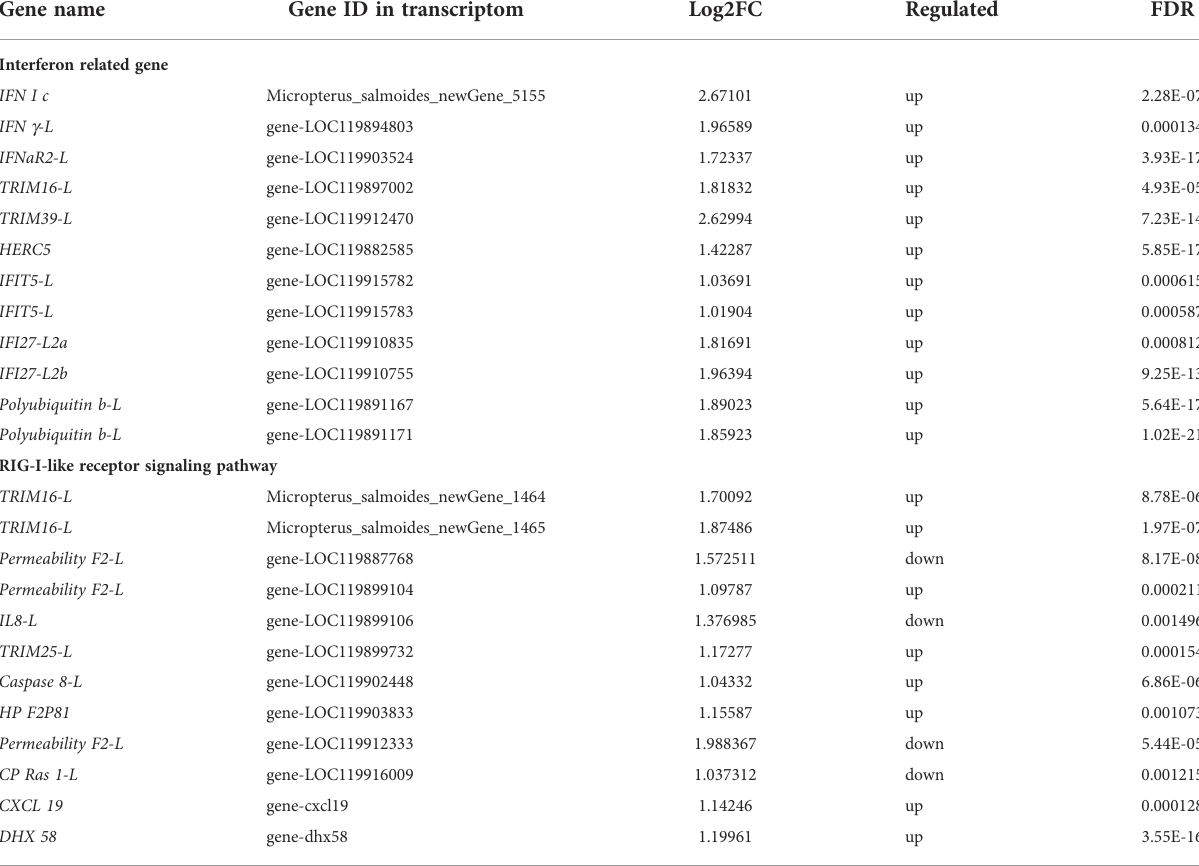
TABLE 1 Partial of DEGs involved in Interferon related gene and RIG-I-like receptor signaling pathway.